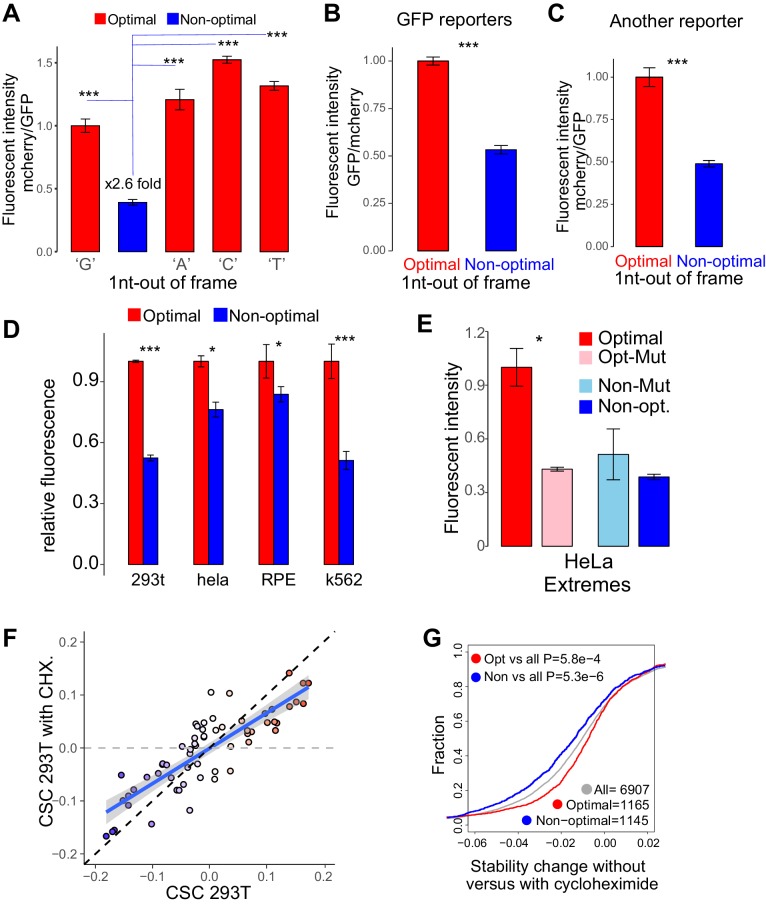
Codon identity affects mRNA stability in human lines in a translation-dependent manner.(A) The 1nt-out of frame reporters enriched in optimal codons present higher mCherry intensity than its non-optimal counterpart independent of the nucleotide (G,A,C,T) used to introduce the frameshift. *p<0.05, **p<0.01 and ***p<0.005 Unpaired t.test for all the panels. (B) The 1nt-out of frame reporter with GFP (replacing mcherry) shows optimality effects at fluorescent intensity. (C) Another pair of 1nt-out of frame reporter, with totally different sequence, shows optimality effects at fluorescent intensity. (D) The 1nt-out of frame reporter shows optimality when we transfected into 293T, HeLa, RPE and K562 cells, with optimal reporter shows higher fluorescent intensity than non-optimal reporter (E) The extreme reporter enriched in optimal codons displayed higher fluorescent intensity than its mutant counterpart. And the reporter enriched in non-optimal codons evidenced lower fluorescent intensity than its mutated pair, when transfected into HeLa cell. (F) Scatter plot for CSC in 293 T cells, with and without Cycloheximide. Every circle is a codon and the color indicates CSC in 293T, linear regression with confident level is indicated with blue line, black dashed line is: y = x. (G) Cumulative distribution of mRNA stability change with and without Cycloheximide from mRNAs enriched in either optimal or non-optimal codons. mRNAs enriched in optimal became less stable in the presence of Cycloheximide and mRNAs enriched in non-optimal codons more stable. P-values indicated, Wilcoxon rank-sum test.